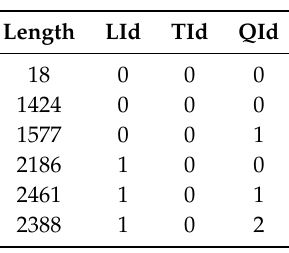
Table 4. Encoder output for a single frame for the crew video.